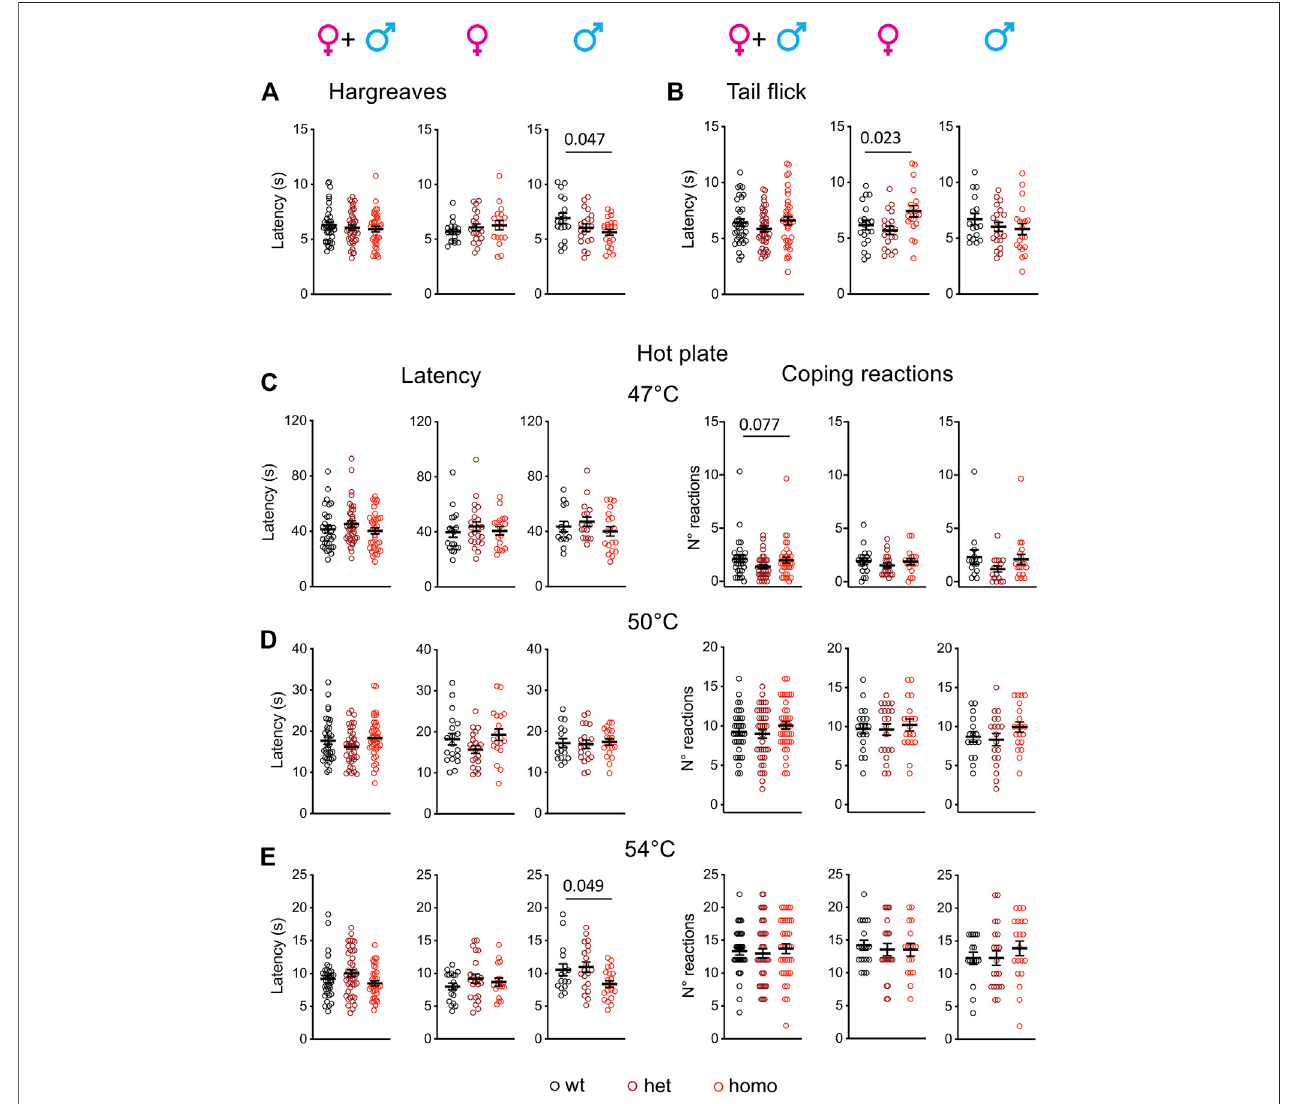
FIGURE 4 | Scn10a G1663S male mice show enhanced pain sensitivity to heat stimuli. (A) Male mutants show increased heat sensitivity in the Hargreaves test. Females n (cid:1) 18 – 21/group; males n (cid:1) 18 – 22/group. One-way ANOVA indicated a genotype difference in males and Sidak ’ s multiple-comparison test showed a signi fi cant difference in wt vs. homozygous males. The bar and p value represent the genotype effect in wt vs. homozygous males. (B) Mutant females had increased latencyinthetail fl icktest.Females n (cid:1) 19 – 20/group;males n (cid:1) 16 – 20/group.Theone-wayANOVAshowedanoverallgenotypedifferenceinfemales.Thebarand p value represent the global genotype effect in females. No genotype effect could be seen in wt vs. heterozygous or wt vs. heterozygous females. (C-E) Hot plate test. Thelatencytothe fi rsthindpawreactionisshowninleftpanelsandthenumberofcopingreactionsinrightpanels. (C) Mutantmiceshowednophenotypeonthe47 ° Chot plate. n (cid:1) 17 – 22/group; males n (cid:1) 14 – 19/group. Kruskal – Wallis analysis on sex-separated or grouped animals showed no genotype difference for fi rst hindpaw sign latency and a trend for coping reactions. The bar and p value represent the global genotype effect for coping reaction in sex-grouped animals. (D) Mutant males or females showed no genotype difference on the 50 ° C hot plate. Females n (cid:1) 19 – 21/group; males n (cid:1) 16 – 20/group. One-way ANOVA on sex-separated or grouped animals. (E) The male mutants were more sensitive than their wt counterparts on the 54 ° C hot plate. Females n (cid:1) 17 – 22/group; males n (cid:1) 16 – 20/group. Kruskal – Wallis analysisshowed aglobalgenotype effect inmales. The bar and p value representthe globalgenotype effect in males. Data are expressed asmeans ± SEMin all panels. See Supplementary Table S7 for detailed statistical